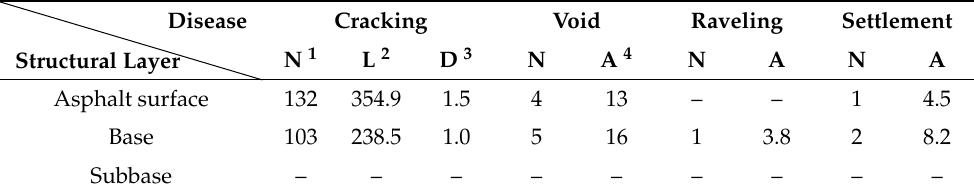
Table 7. The defects detection results of the left side of road. LayerDisease Structural